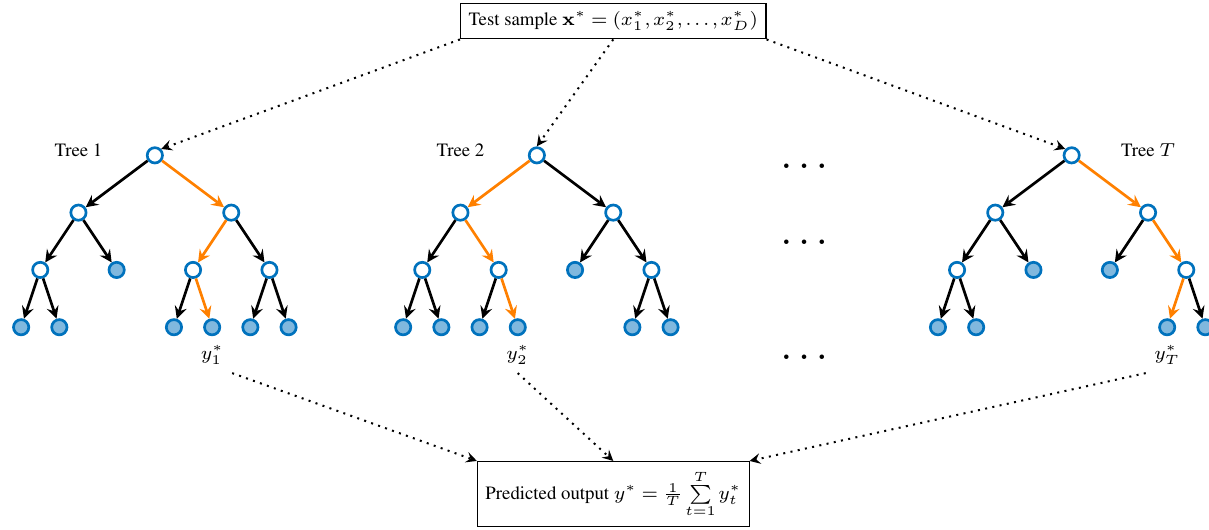
Figure 2. Predicting the output y ∗ of a sample x ∗ with a randomized decision forest is carried out by averaging the individual predictions obtained from the T decision trees in the